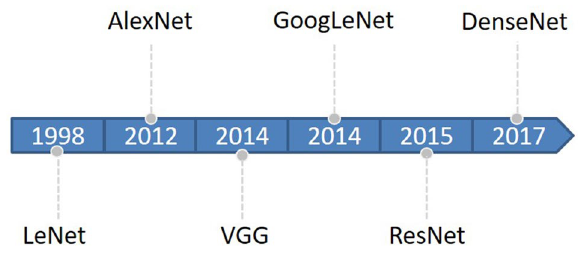
Figure 1. Evolution timeline of CNNs from LeNet to